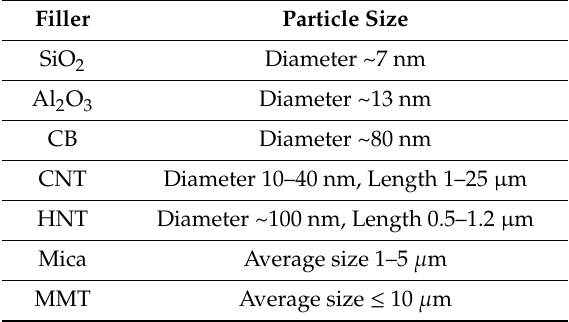
Table 2. Dimensional specifications of filler